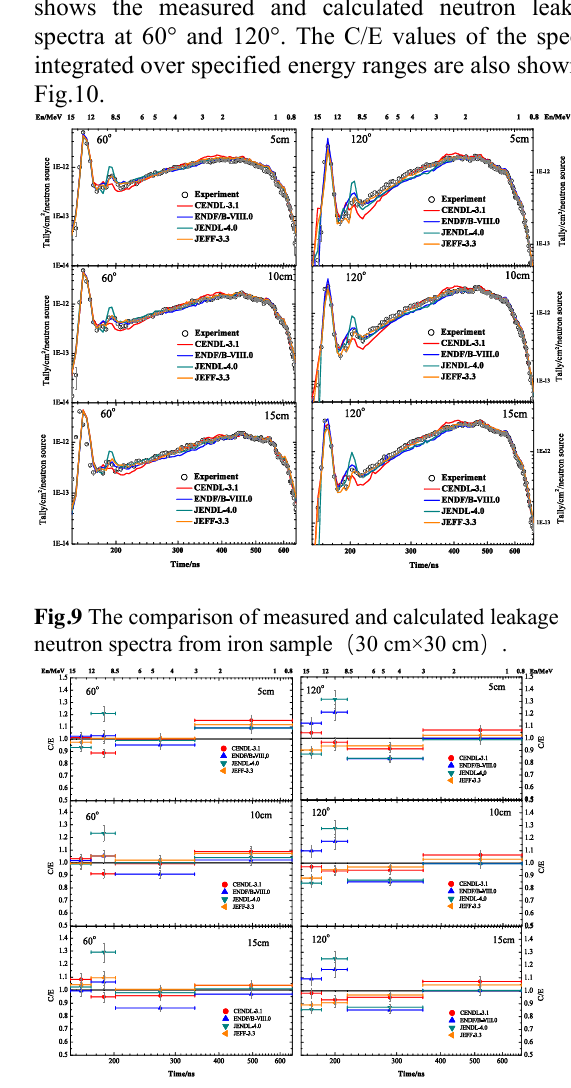
Fig.10 The C/E values integrated over the specified energy ranges at 60° (30 cm×30 cm).